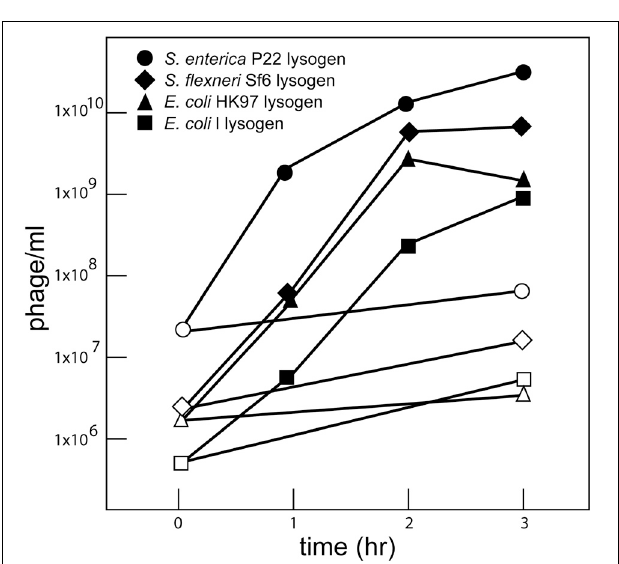
FIGURE 1 | Carbadox induction of Enterobacteriaeae prophages. Bacterial strains lysogenized with P22 (UB-1790), λ (UB-1703), HK97 (UB-1704), and Sf6 (UB-1496) were grown in LB broth at 37 ◦ C with shaking. At a density of 1 × 10 8 bacterial cells/ml, carbadox was added to a final concentration of 0.5 μ g/ml. Phage lysates were obtained by shaking with chloroform at the indicated times after carbadox addition and titered on a permissive host. Open symbols indicate cultures with no added carbadox and closed symbols indicate cultures with carbadox added. The different induced lysogens are indicated in the figure